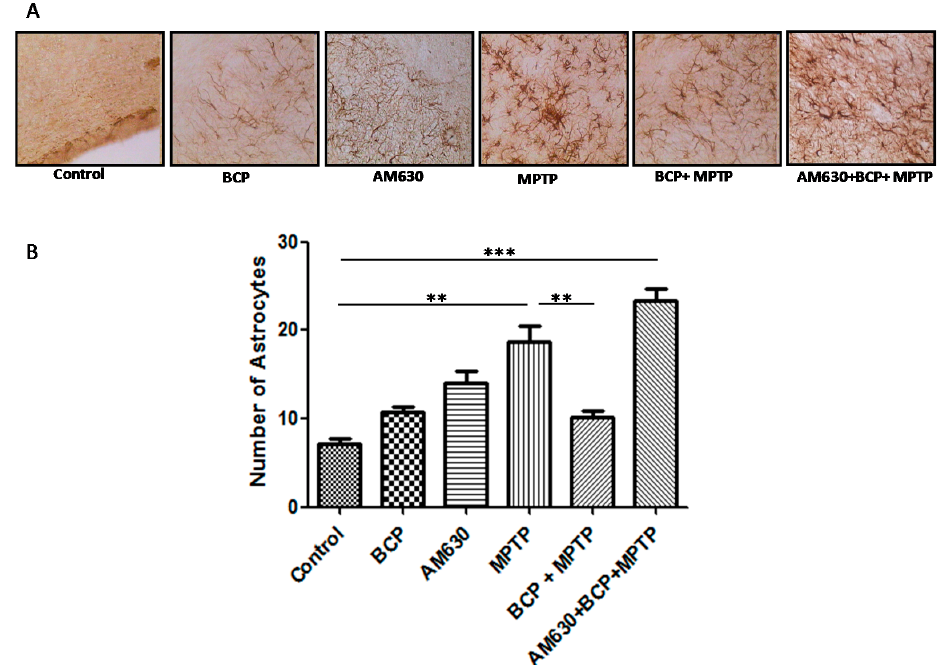
Figure 6. Effect of BCP on MPTP-induced astrocyte activation in the mouse SNpc. ( A ) Glial fibrillary acidic protein (GFAP)-IR astrocytes in mouse SNpc. Scale bar: 200 μ m. ( B ) Stereological cell counts of GFAP-IR neurons. The data are presented as the mean ± SEM of six individual experiments. ** p < 0.01, CTL vs. MPTP treatment. ** p < 0.01, MPTP treatment vs. BCP + MPTP treatment.*** p < 0.001, CTL vs. AM630 + BCP + MPTP treatment.